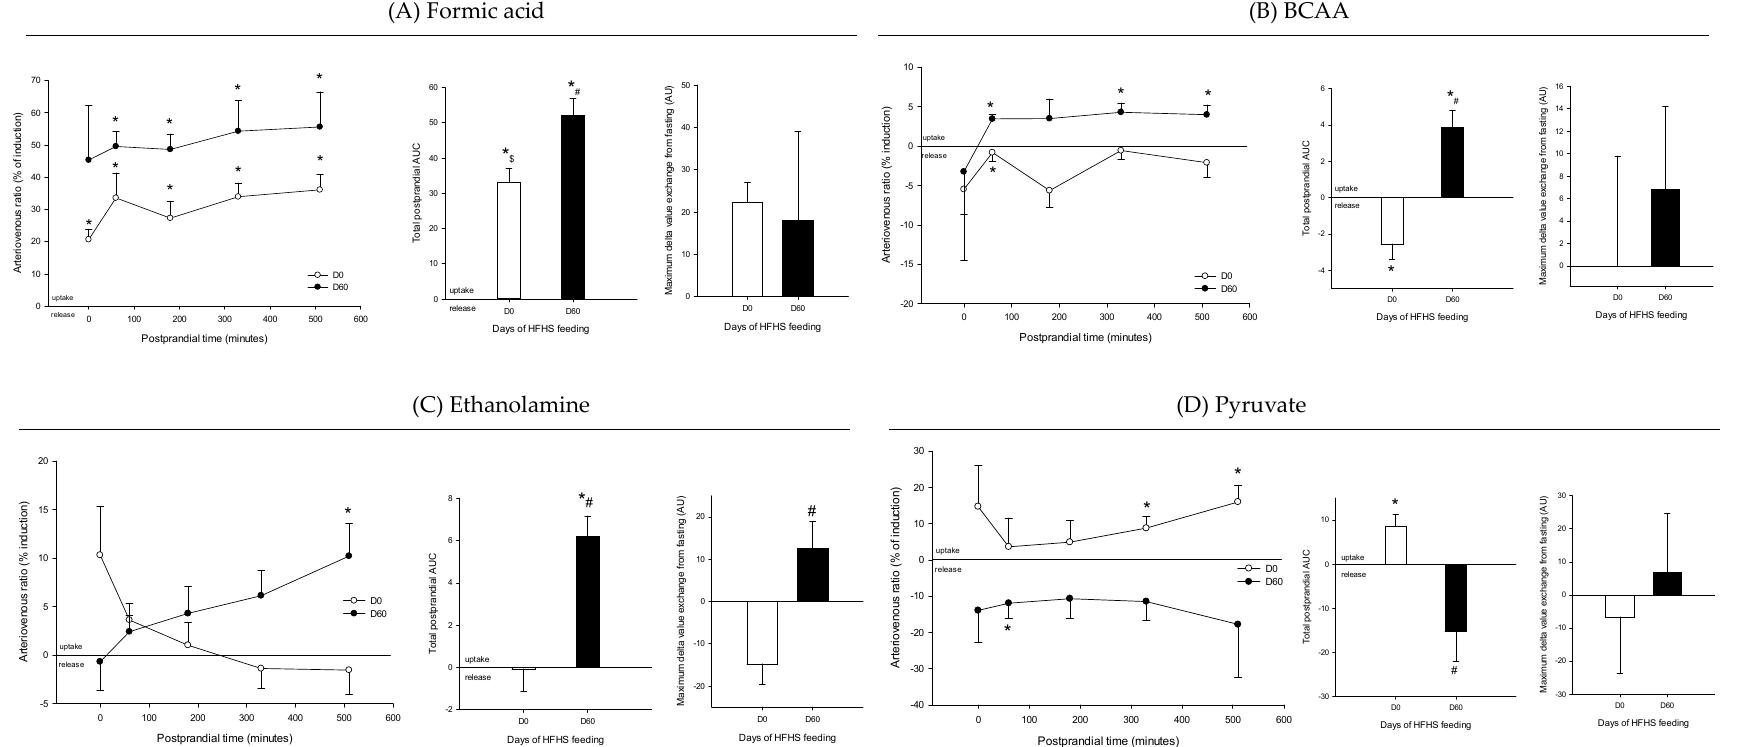
Figure 6. Arteriovenous fold change (A/V) of ( A ) formic acid, ( B ) branched-chain amino acids (BCAA), ( C ) ethanolamine, and ( D ) pyruvate across the liver on five Yucatan mini-pigs submitted to a HFHS diet during two months. Data is presented in % of induction (mean + sem) and the exchange was analyzed using a repeated-measures t -student test. *, significantly different from 0 (equilibrium), p < 0.05. For the A/V ratios and total postprandial AUC, positive values = taken up by the organ; negative values = released by the organ. #, significantly different from D0, p < 0.05; $, significantly different from the fasting condition, p < 0.05. The maximum delta value exchange from fasting is also presented: the positive and negative values represent an increase or decrease exchange following the meal respectively.